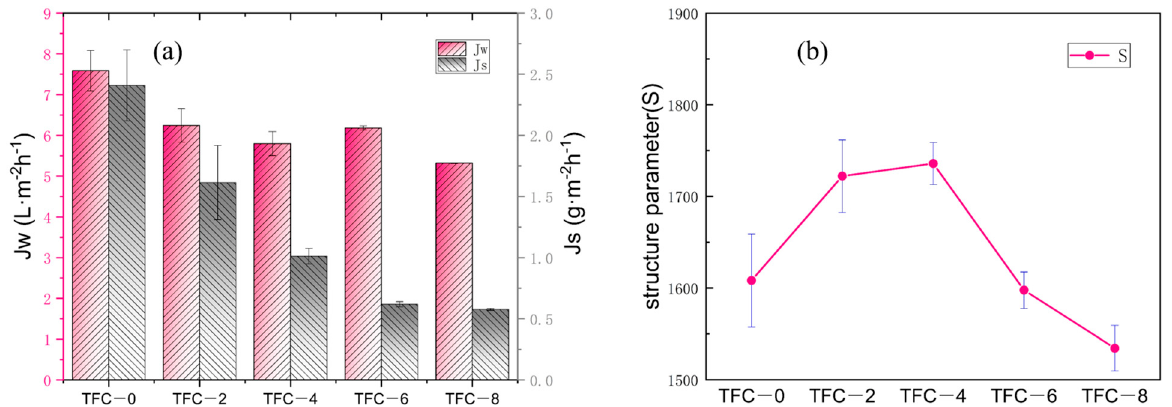
Figure 5. Water and salt transport properties of polyamide thin-film composite membranes: ( a ) membrane performance; ( b ) structure parameters S.